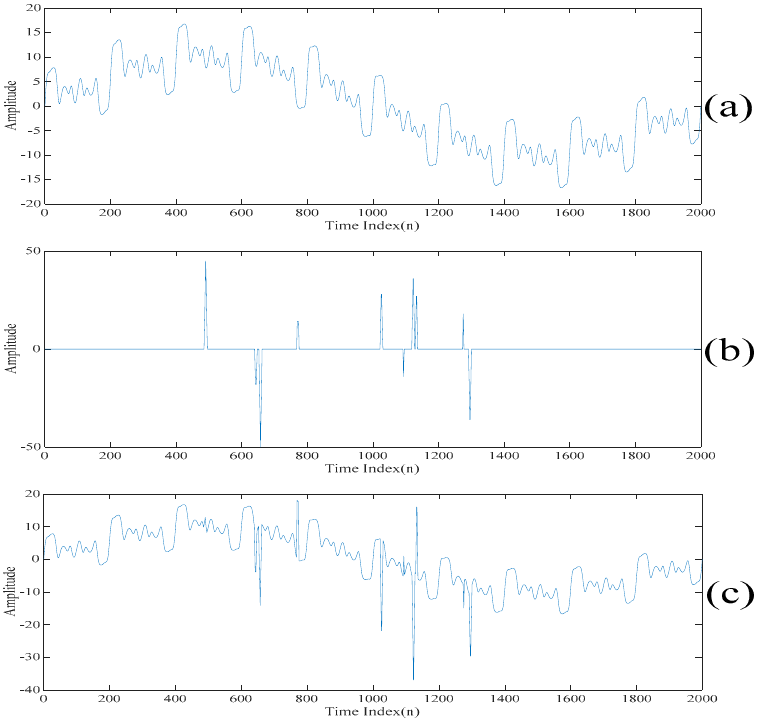
Figure 19. ( a ) The clean signal s ∗ ( n ) . ( b ) The spike signal η ∗ ( n ) . ( c ) The synthetic signal s ( n ) Table 4. The signal to noise ratios of the despiked signals obtained by the above four denoising methods.